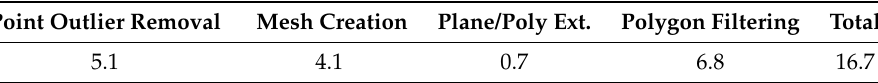
Table 5. Mean Execution Timings (ms) of Polylidar3D on KITTI.